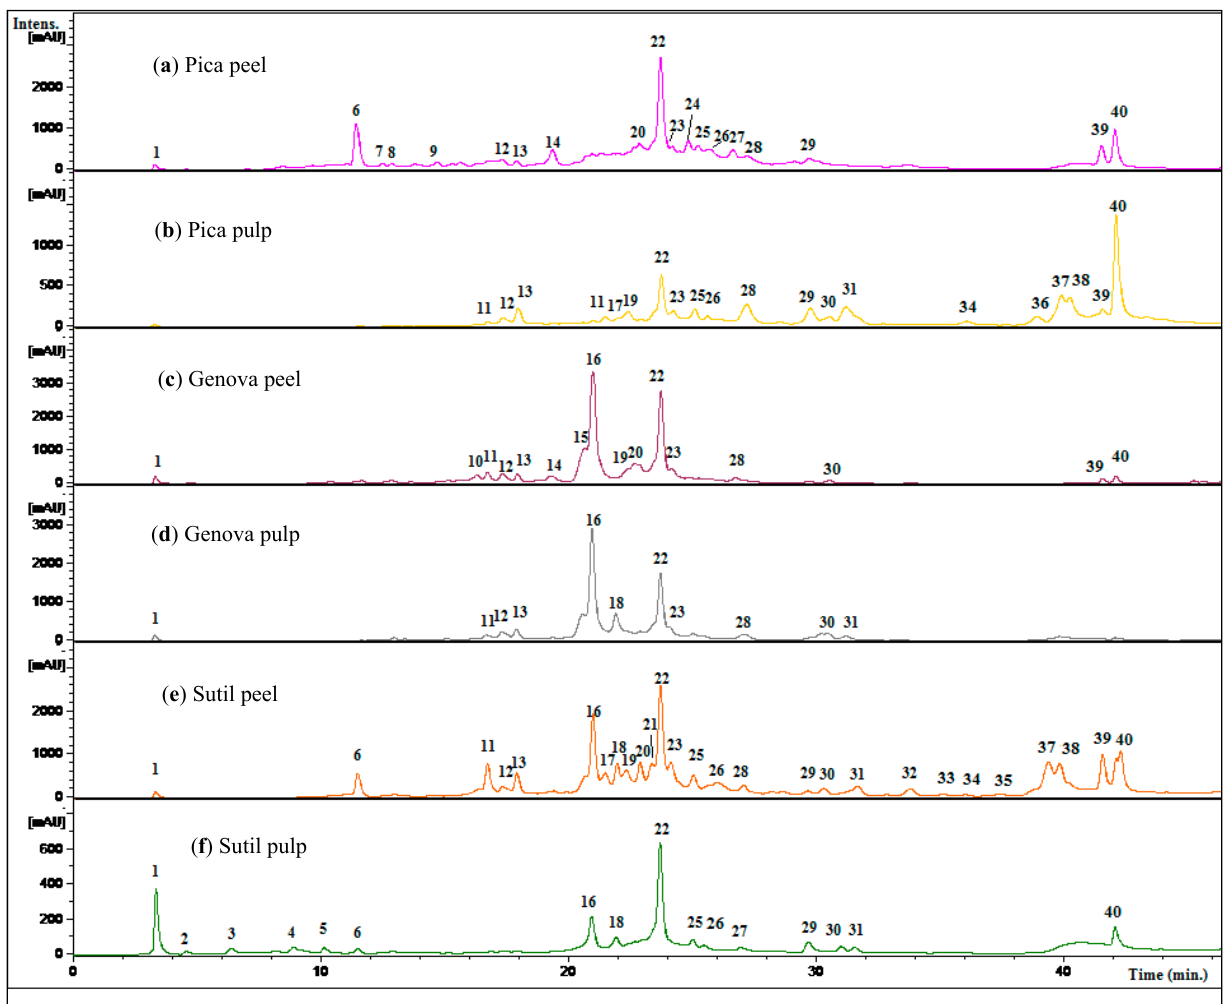
Figure 3. HPLC-UV chromatograms of Citrus fruits from northern Chile. ( a ) Pica lemon peel; ( b ) Pica lemon pulp ( c ) Genova lemon peel ( d ) Genova lemon pulp; ( e ) Sutil lemon peel and ( f ) Sutil lemon pulp, monitored at 280 nm. Peak numbers refer to those indicated in Table 1.